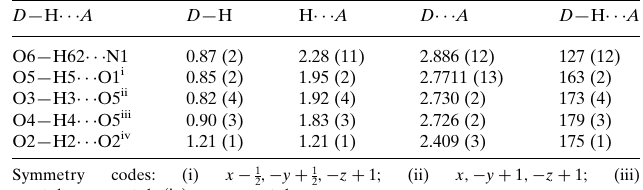
Hydrogen-bond geometry (A˚ , (cid:5)